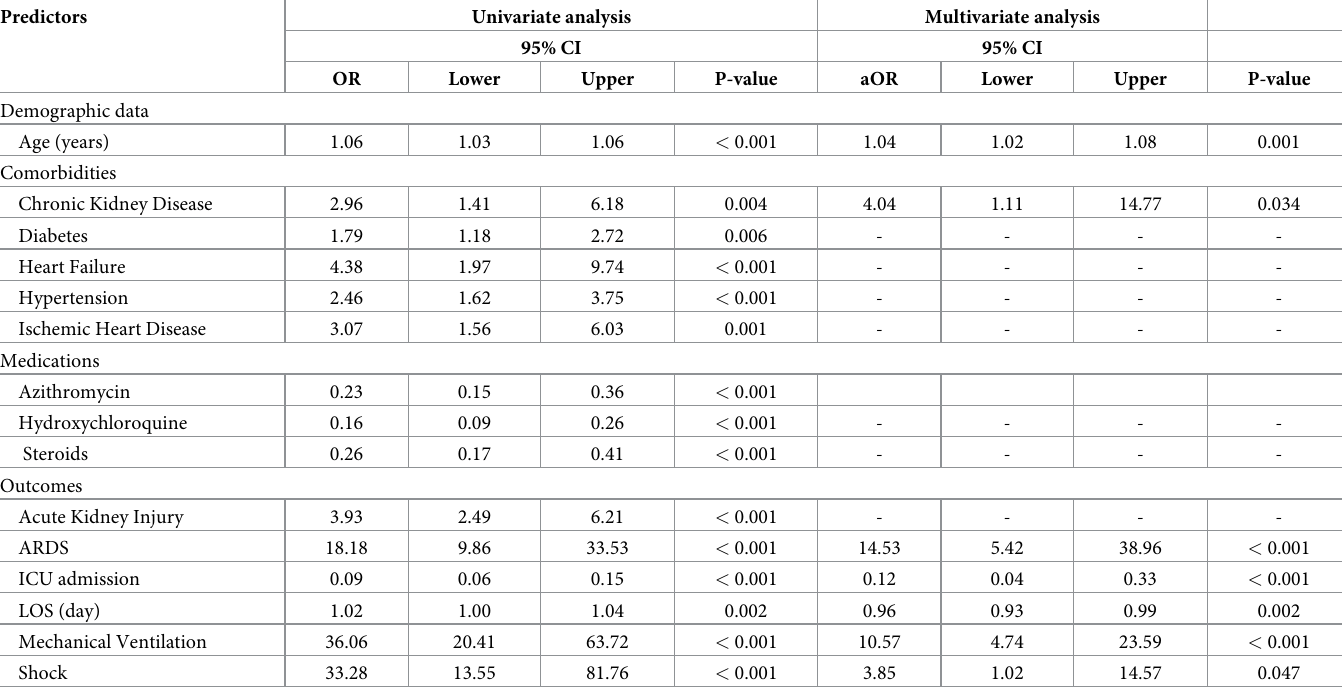
Table 4. Univariate and multivariate logistic regression analysis of the risk factors associated with mortality among COVID-19